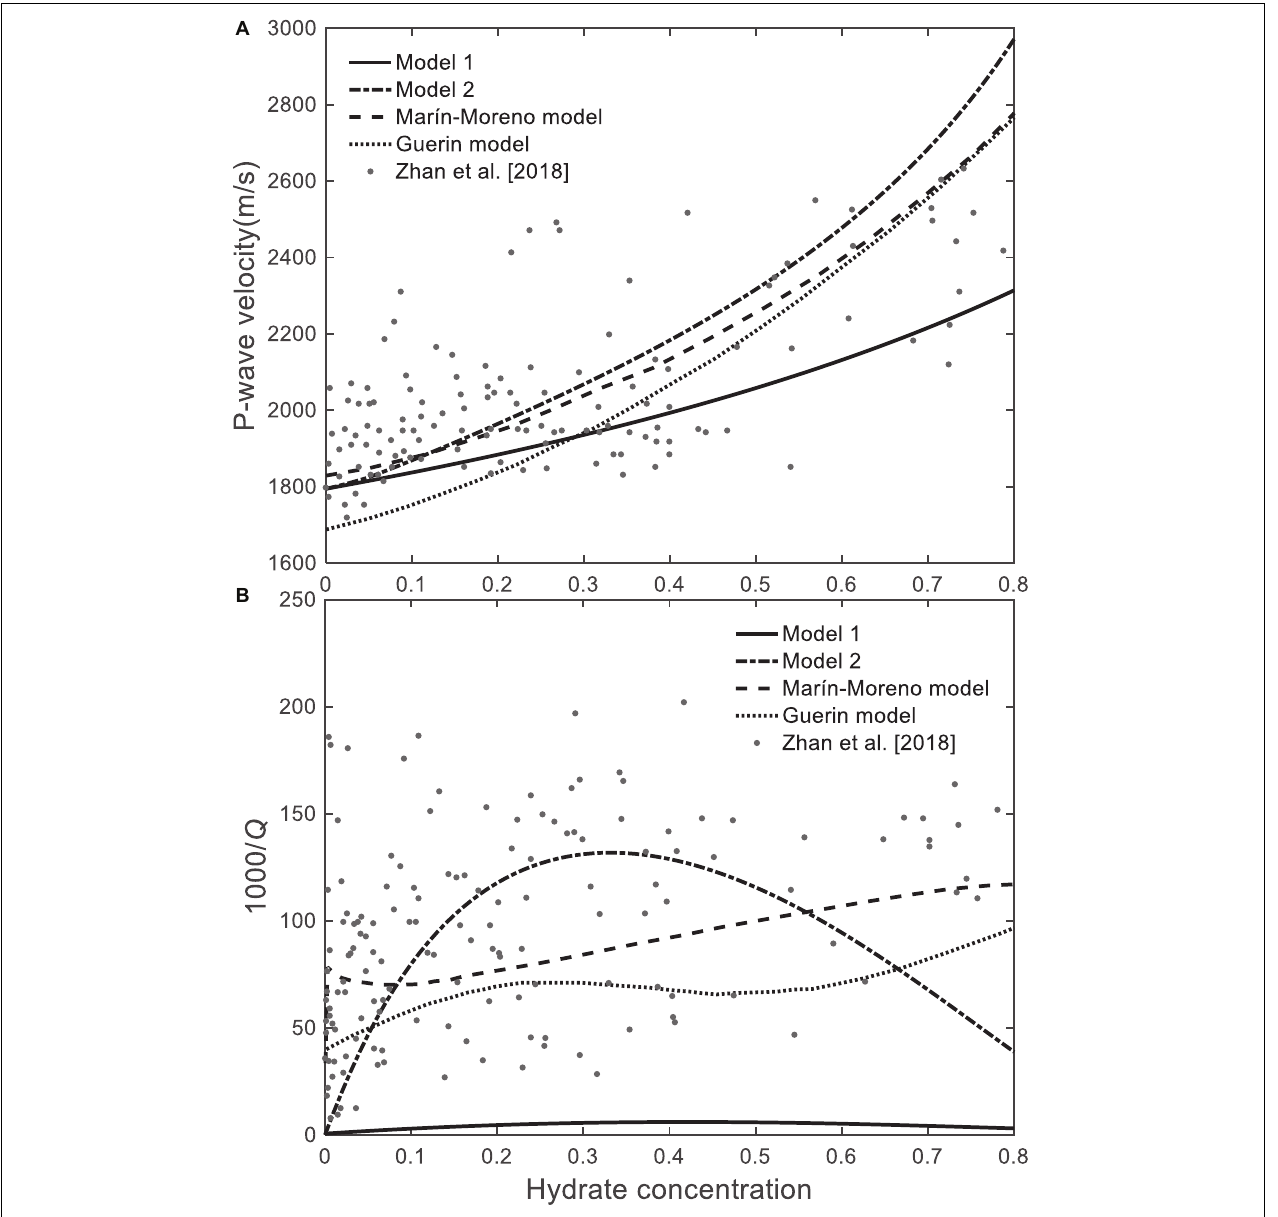
FIGURE 15 | Model comparison with those of the other authors. (A) P-wave velocity and (B) dissipation